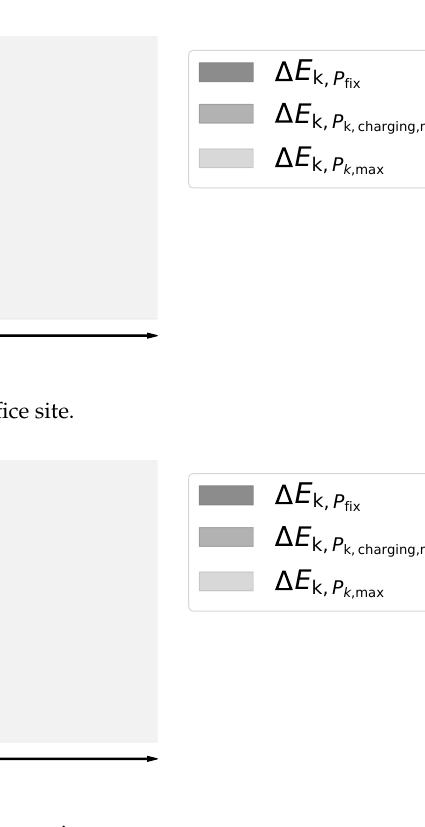
Figure 13. FlexBars for the agency